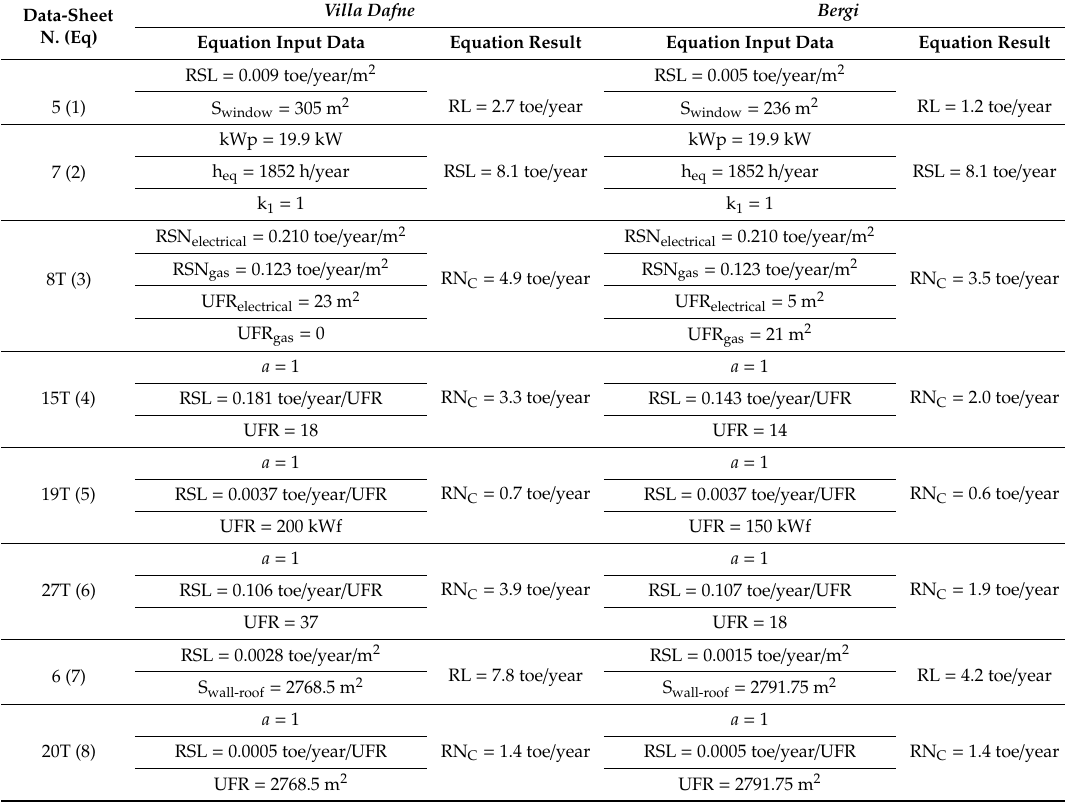
Table A3. Equations (A1) to (A8) input data parameters for the two considered agritourisms. Data-Sheet N.